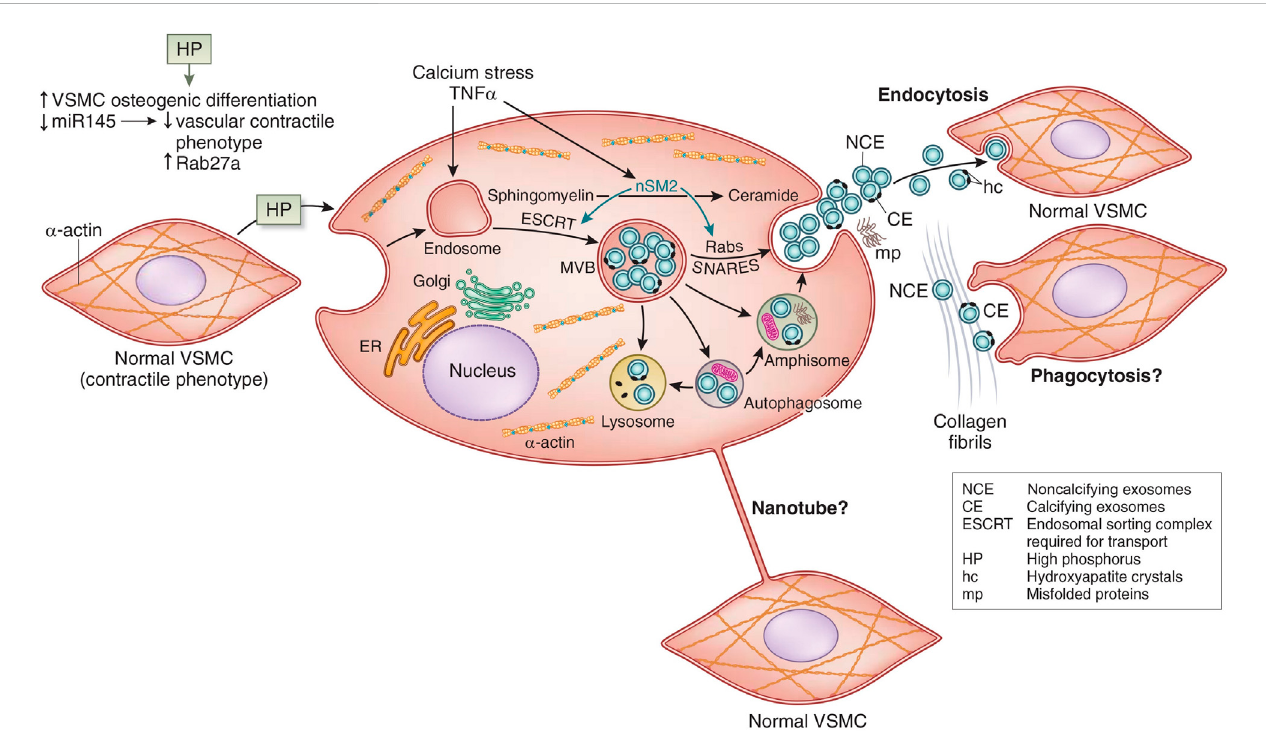
FIGURE 4 Vascular smooth muscle cell (VSMC) exosome biogenesis and release. See text for interpretation. miR145, micro RNA 145; ER, endoplasmic reticulum; TNF- α , tumor necrosis factor alpha; MVB, multivesicular bodies; nSM2, neutral sphingomyelinase 2; SNARES (Soluble NSF Attachment protein Receptor Superfamily). Adapted from Dusso et al. (2018) with